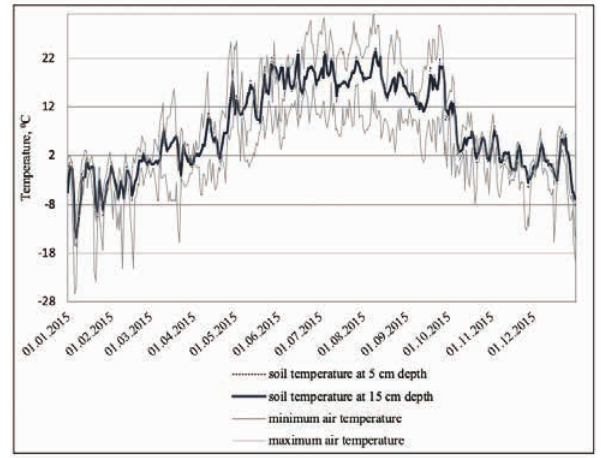
Figure 3: Air and soil temperature in Table 4: Climatic temperature and rainfall classes for differentiating